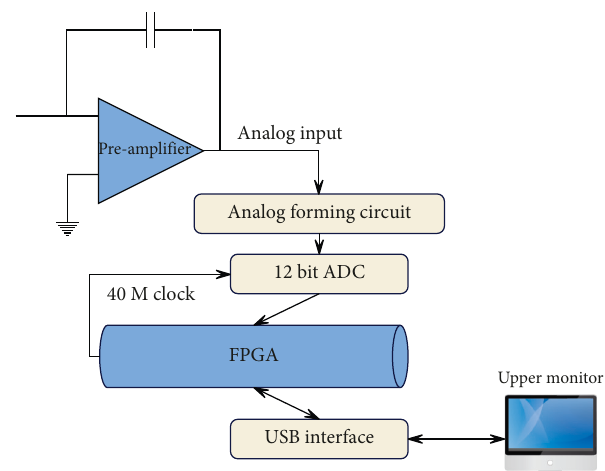
Figure 4: Schematic diagram of the structure of the real-time processing digital